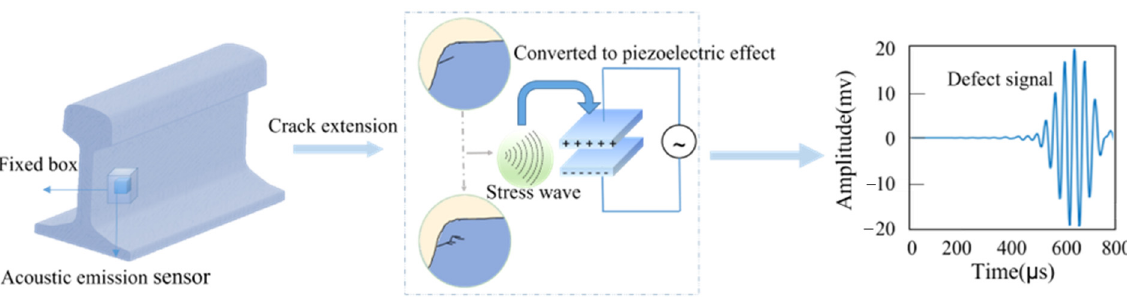
Figure 2. AE sensor detection. Table 2. Comparison of acoustic emission methods.